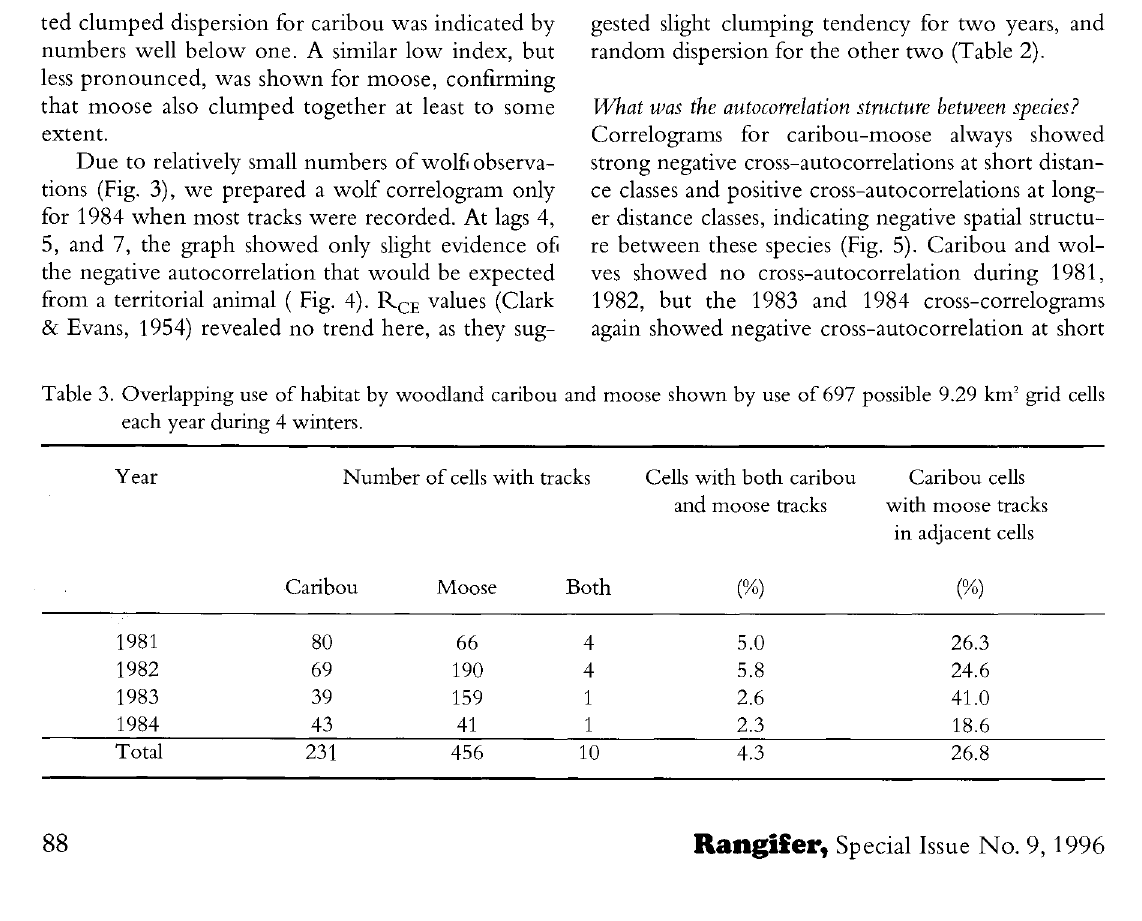
Fig. 5. Spatial cross-correlograms based on standard normal deviates (SND) for pairs of species show negative correlati ons at shorter distances, indicating that an individual is not as likely to be found near another species as would be expected by chance. Black squares represent significant values at the a=5% level; white squares are non-signifi cant values. Distance classes were 3.8 km.